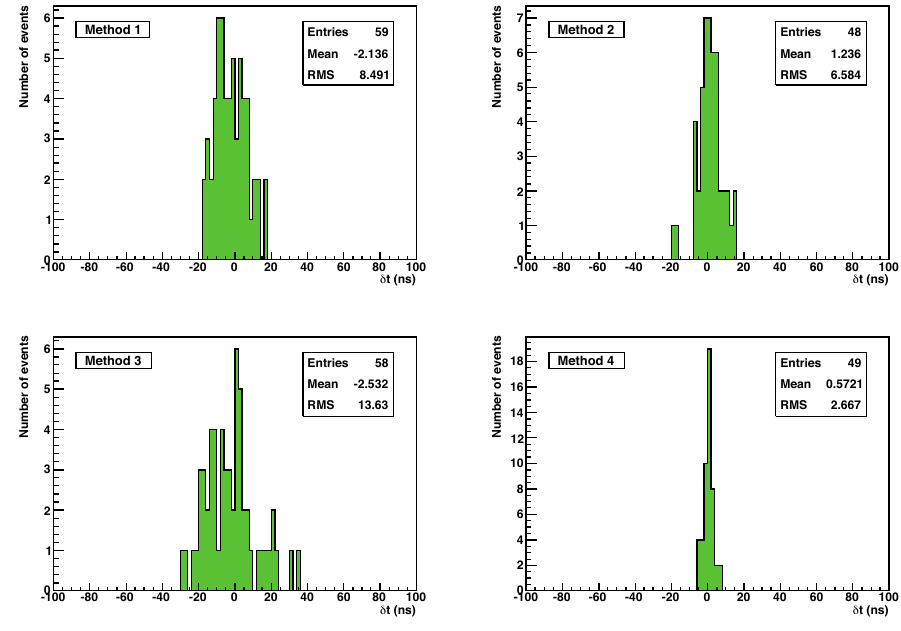
Figure 6. Neutrino time distribution for events selected for the TT analysis using the first hit (Method 1), for the TT analysis using all muon hits (Method 2), for events selected for the RPC analysis using all muon hits (Method 3) and for events selected for the RPC analysis using the trigger boards (Method